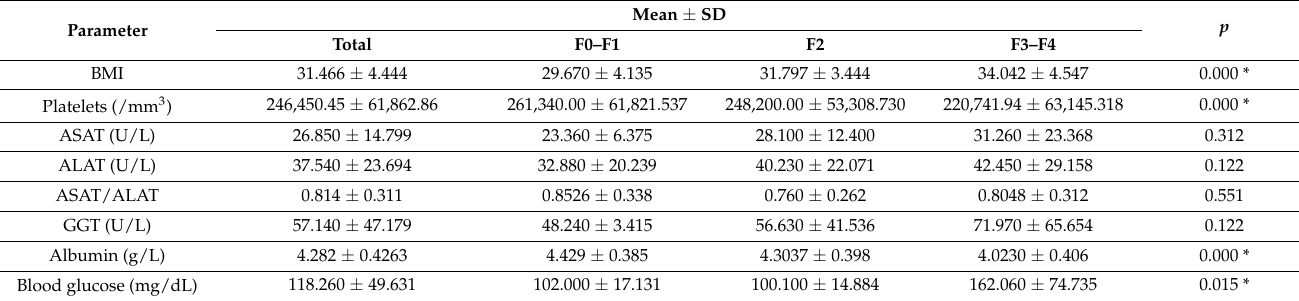
Table 2. Comparative study of parameters analyzed by grade of